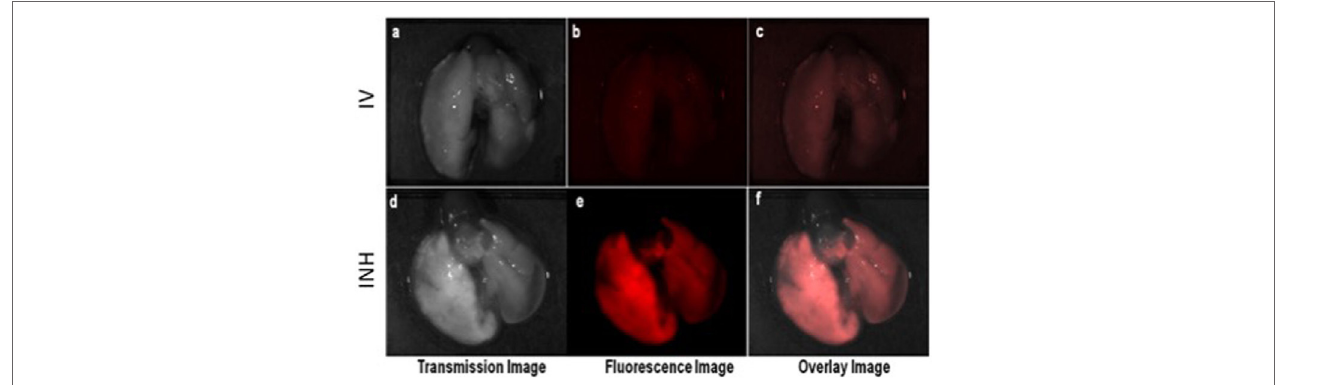
FiGUre 2 | Ex vivo optical studies with the lung dissected from the mice administered with nanoparticle drones. Fluorescent imaging illustrating the distribution of fluorescent drones within the mouse lung administered via intravenous (IV) in panels (A–c) and inhalation (INH) in panels (D–F)